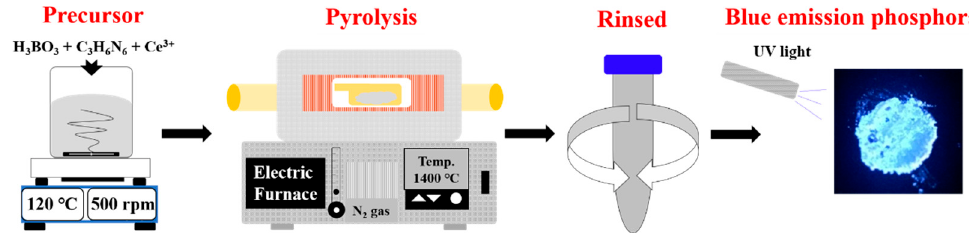
Figure 1. Schematic of preparation of the Ce 3+ -doped h-BN nanophosphors.